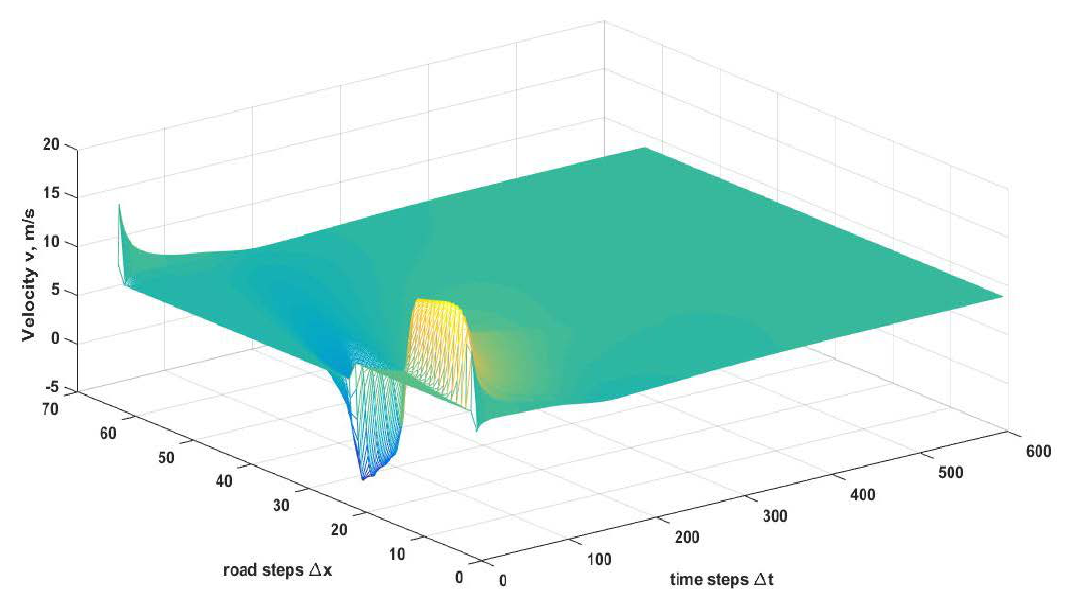
Figure 6. Velocity with the PW model on a 300 m circular road with τ = 2.5 s and C 0 =